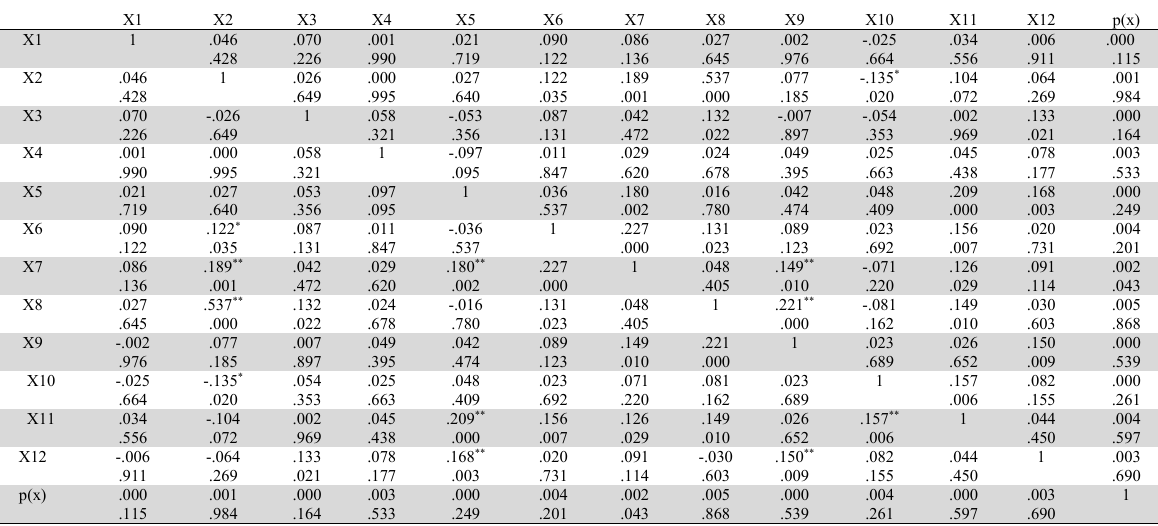
The results of correlation between different